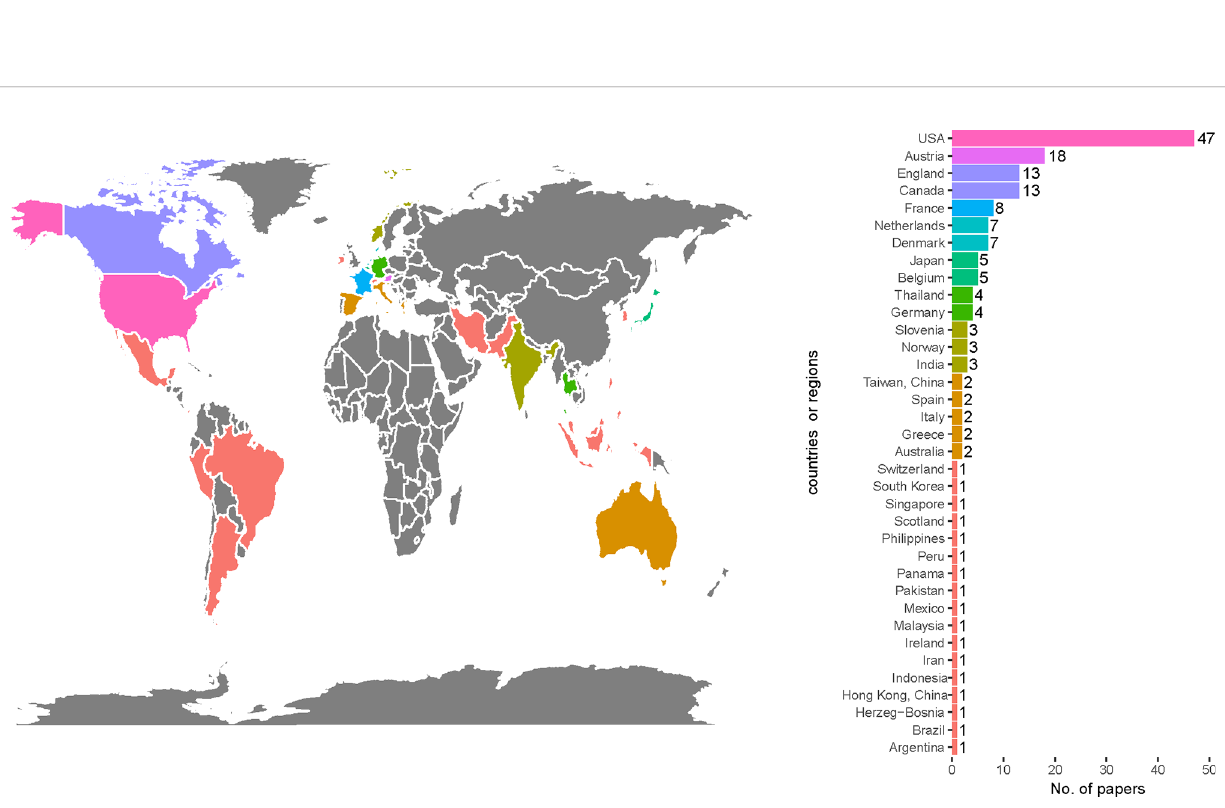
Frontiers in Oncology |